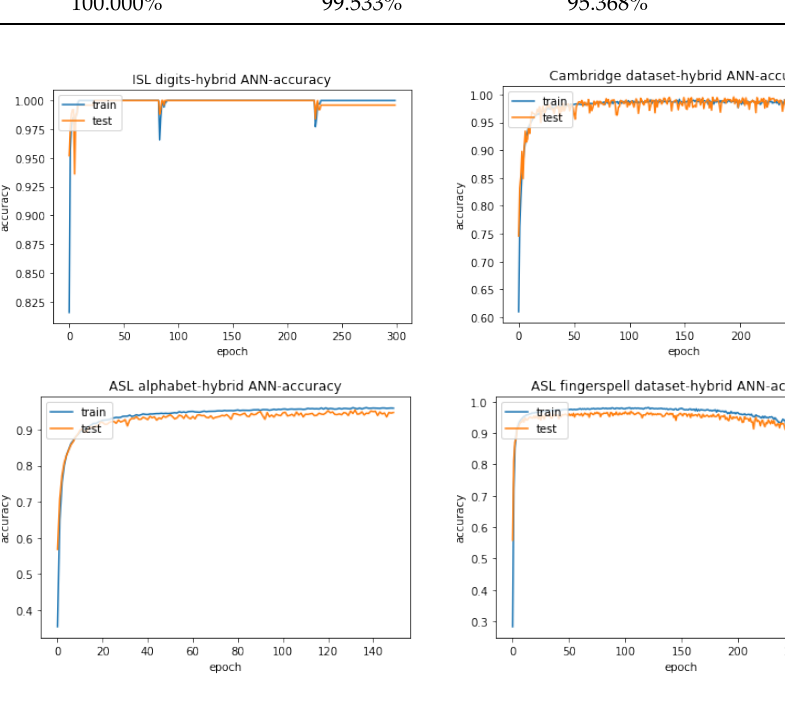
Figure 10. Hybrid ANN accuracy curves.